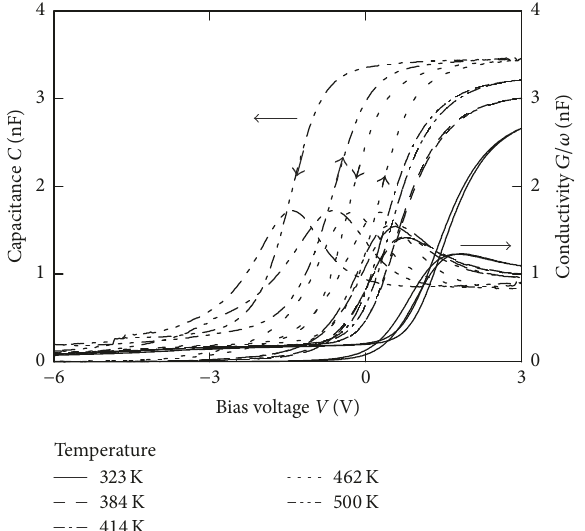
Figure 1: C-V and G-V curves of the Au/Zr (3nm)/YSZ (40 nm)/ 𝑛 - Si MOS stack measured at various temperatures. Ramp voltage sweep rate 𝛽 = 0.04 V/s, measurement frequency 𝑓 = 100 kHz.